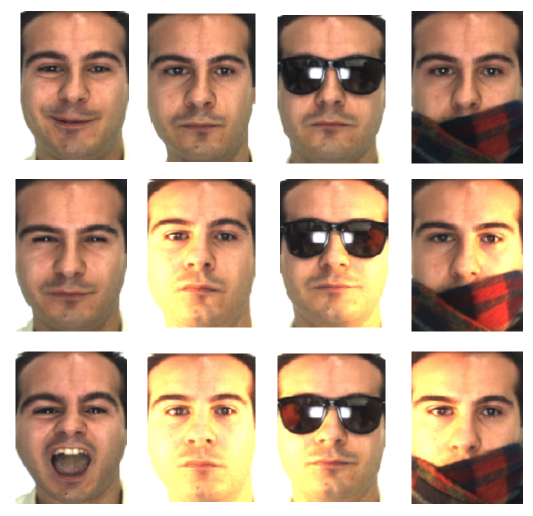
Figure 7. Aleix Martinez and Robert Benavente (AR)